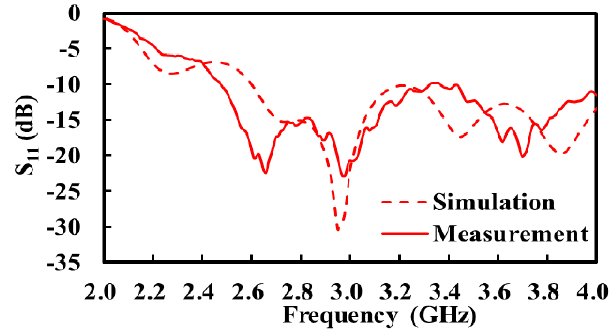
Figure 6. Simulated and measured S 11 of the fabricated horn antenna.